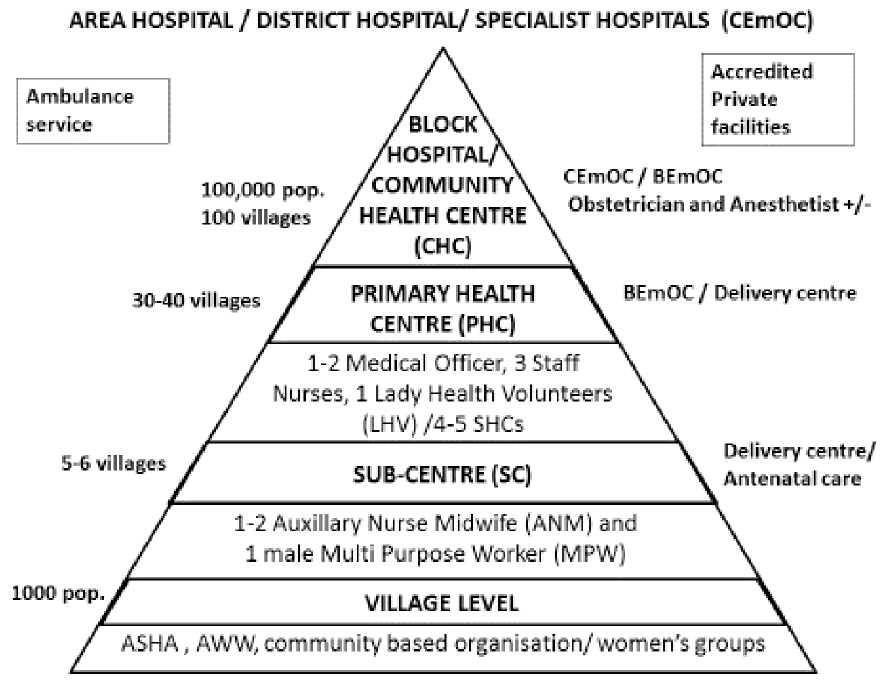
Fig 1. Rural public health system for obstetric care in